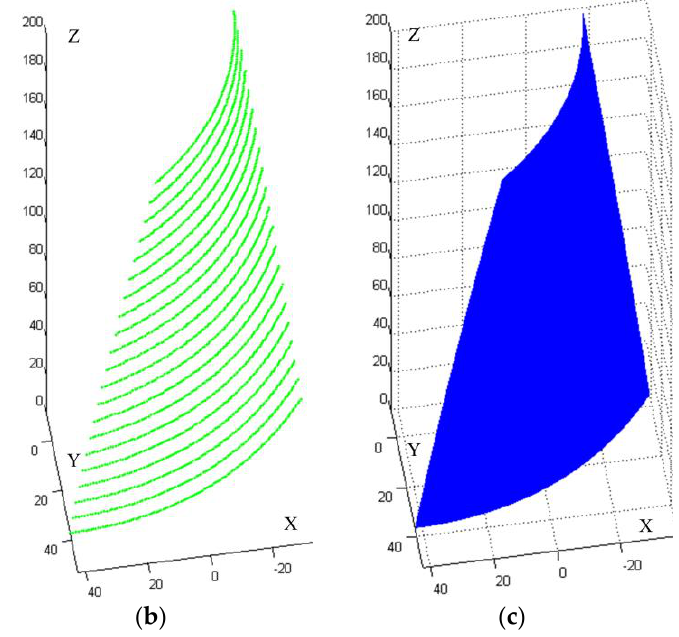
Figure 12. Surface fitting of a blade surface: ( a ) a diagram of the measurement; ( b ) the original grid data; ( c ) the randomly chosen data; ( c ) the fitting NURBS surface.